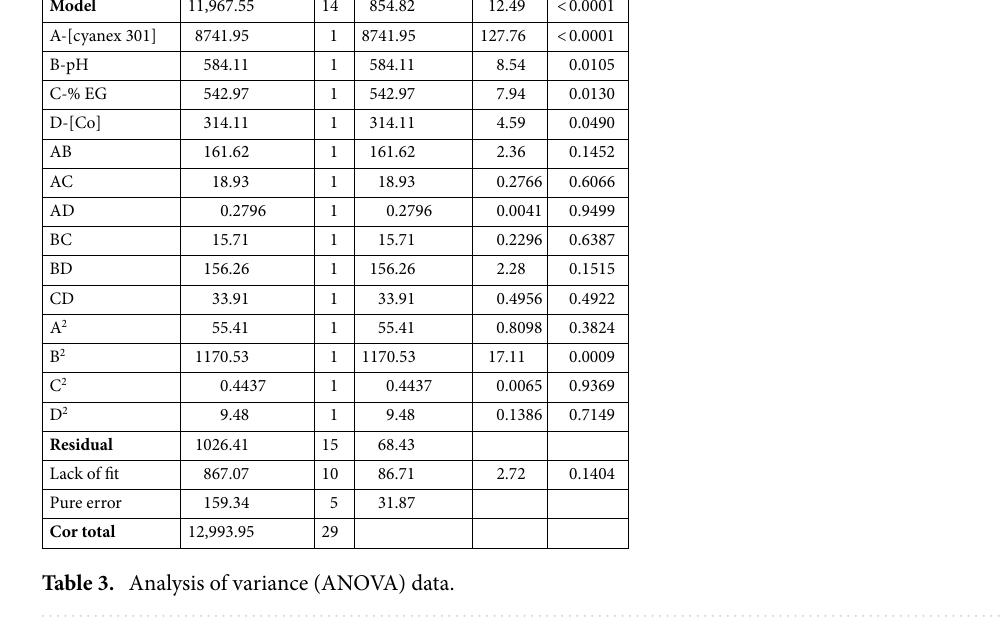
were chosen as the concentration of Cyanex 301 (0.05 M), the concentration of cobalt (833 ppm), the pH (3.5), and the percent of EG (80%). The test was carried out in a 15 mL test tube, and the test extraction percentage matched that of the test design. The validation of data observed with the minimum errors between the predicted data (93.505%) and actual data (98.275%).